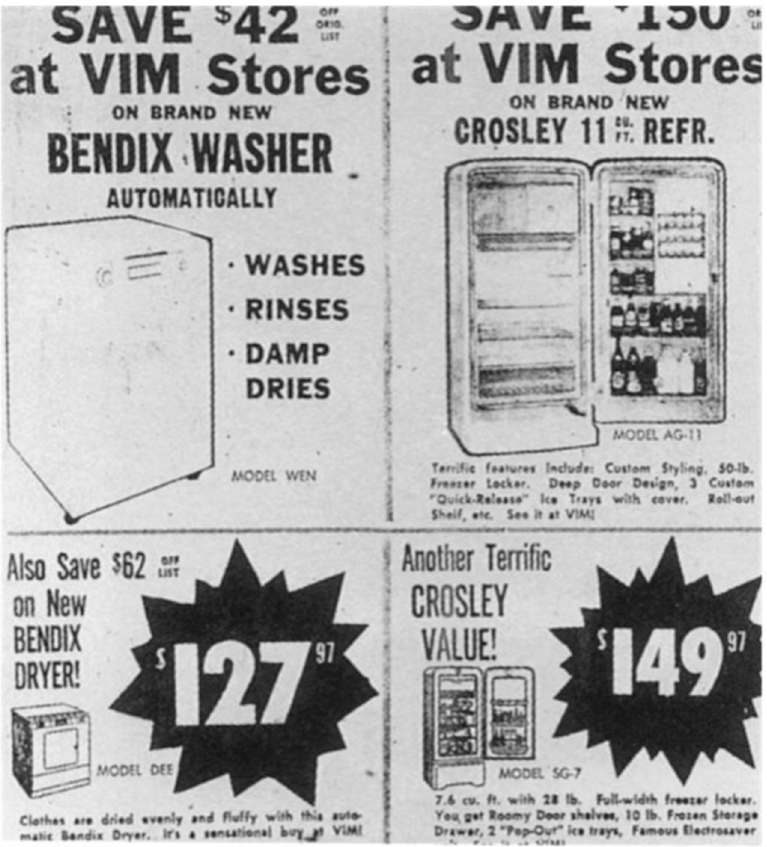
Figure 7. Advertisement for Crosley refrigerators, New York Journal-American, 1 April 1956, sec. L, p. 20.